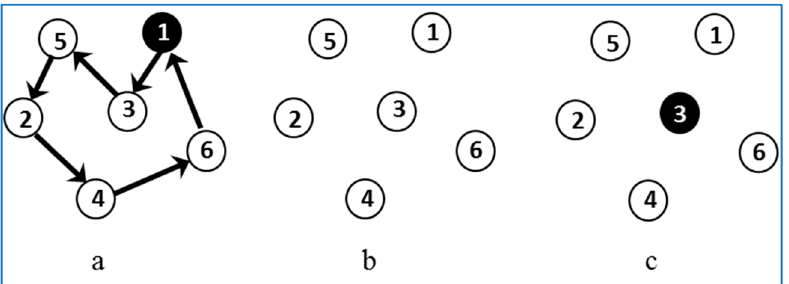
Figure 5. The collecting center removal operator. ( a ) The current solution: number 1 is the collecting center. ( b ) Close collecting center number 1. ( c ) Choose number 3 as the new collecting center.